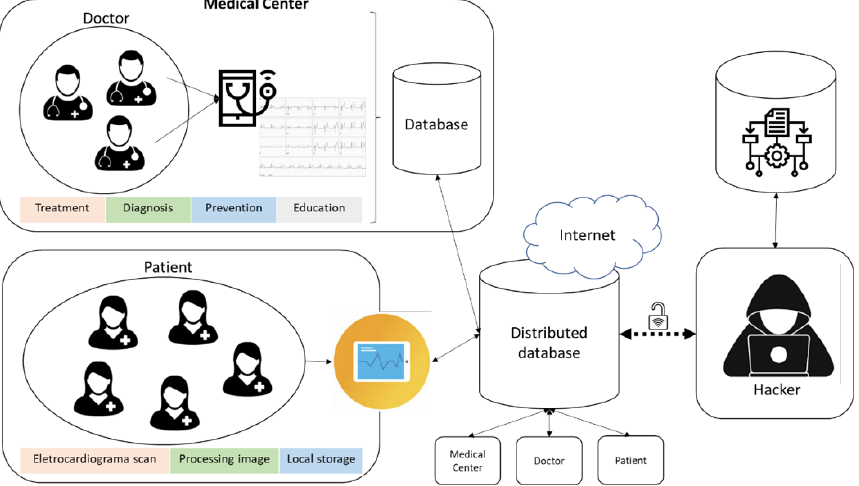
Figure 1. Cyberattacks in telemedicine services.